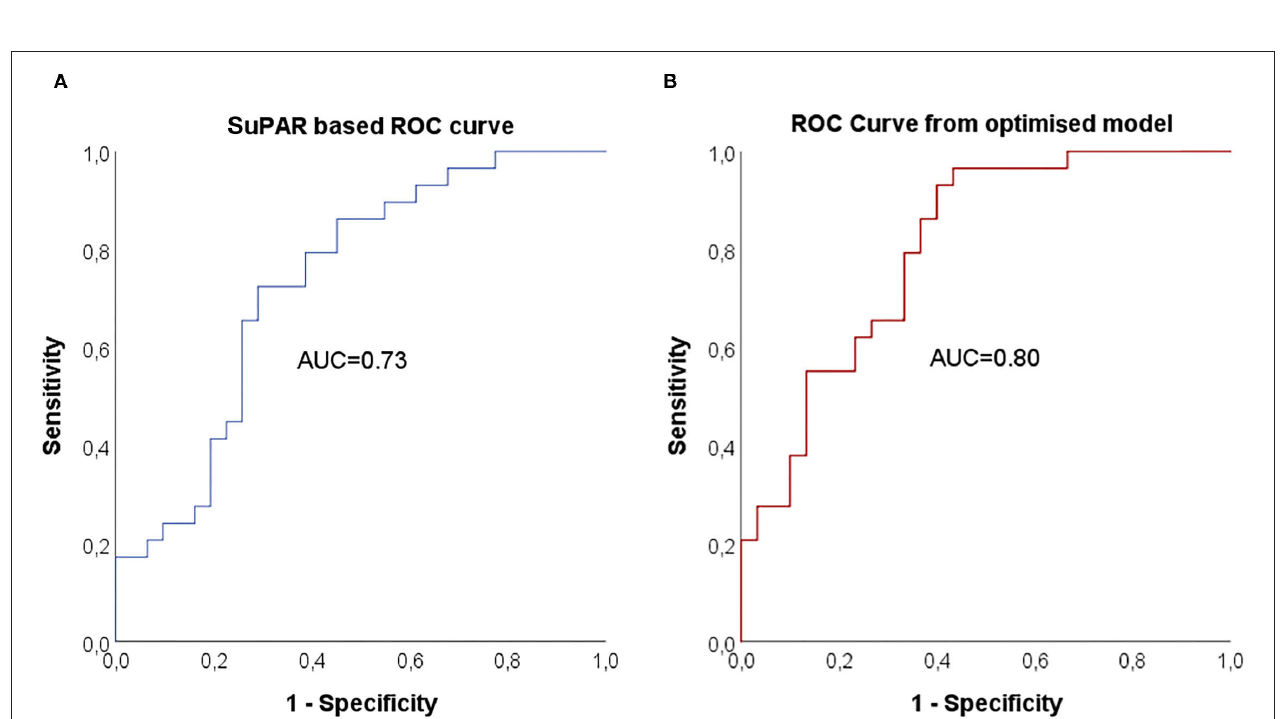
FIGURE 4 | Receiver operating characteristic (ROC) curve and area under curve (AUC) for prediction of COVID-19 severity. AUC for suPAR based prediction of COVID-19 severity (A) and AUC for predicted probabilities from the optimised model with suPAR, BMI and NLR (B) .